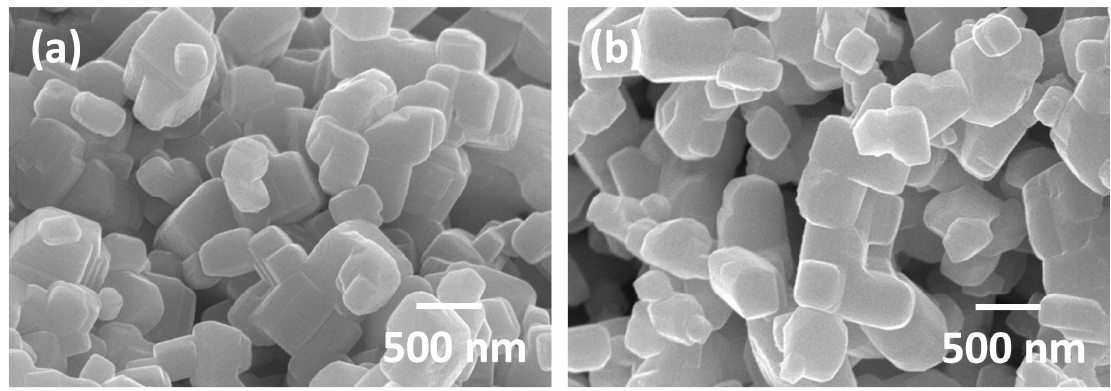
Figure 7. SEM micrographs of KNbO 3 powder annealed at 1040 °C for 1 h in ( a ) O 2 and ( b ) H 2 .